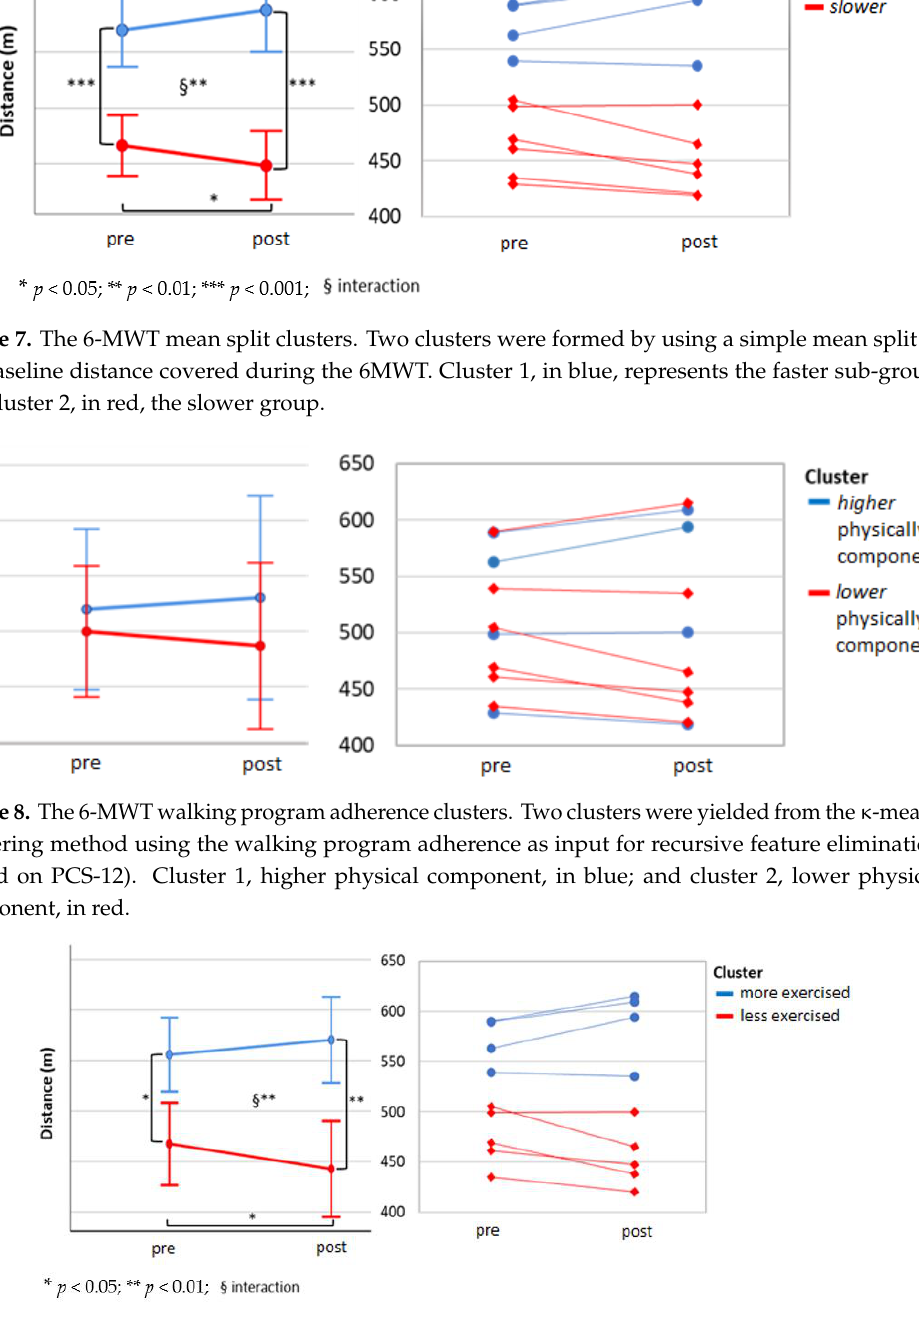
Figure 9. The 6-MWT exercise program adherence clusters. Two clusters were yielded from the κ -means clustering method using the exercise volume adherence as input for recursive feature elimination (based on APQ, HRrest). Cluster 1, more exercised, in blue; and cluster 2, less exercised, in red.